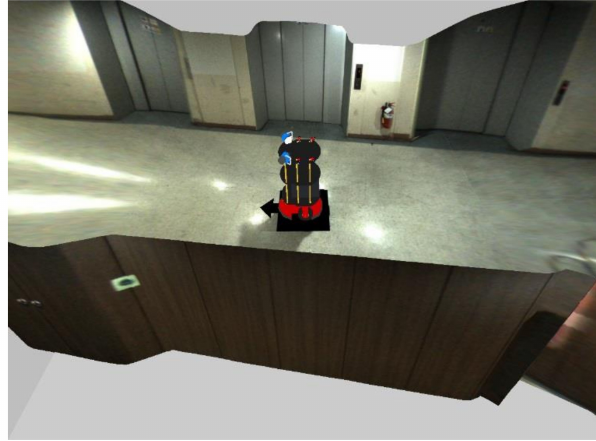
Figure 11. An example of mapping the stitched RoI A and B images to the spatial model. The regions of the yellow and blue lines are the RoI B and RoI A images in Figure 7. The region of the red line is the same as the region of the red line in Figure 10.